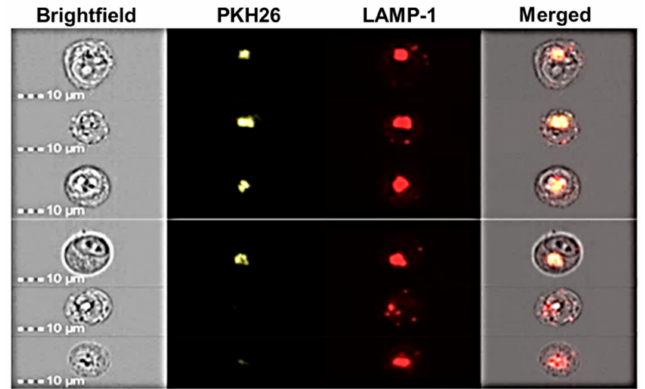
Figure 11. Image cytometry of K-562 cells intracytoplasmic labelled with Alexa fluor 647-conjugated anti-human CD107a (LAMP-1) antibody and treated with labelled CH/HY